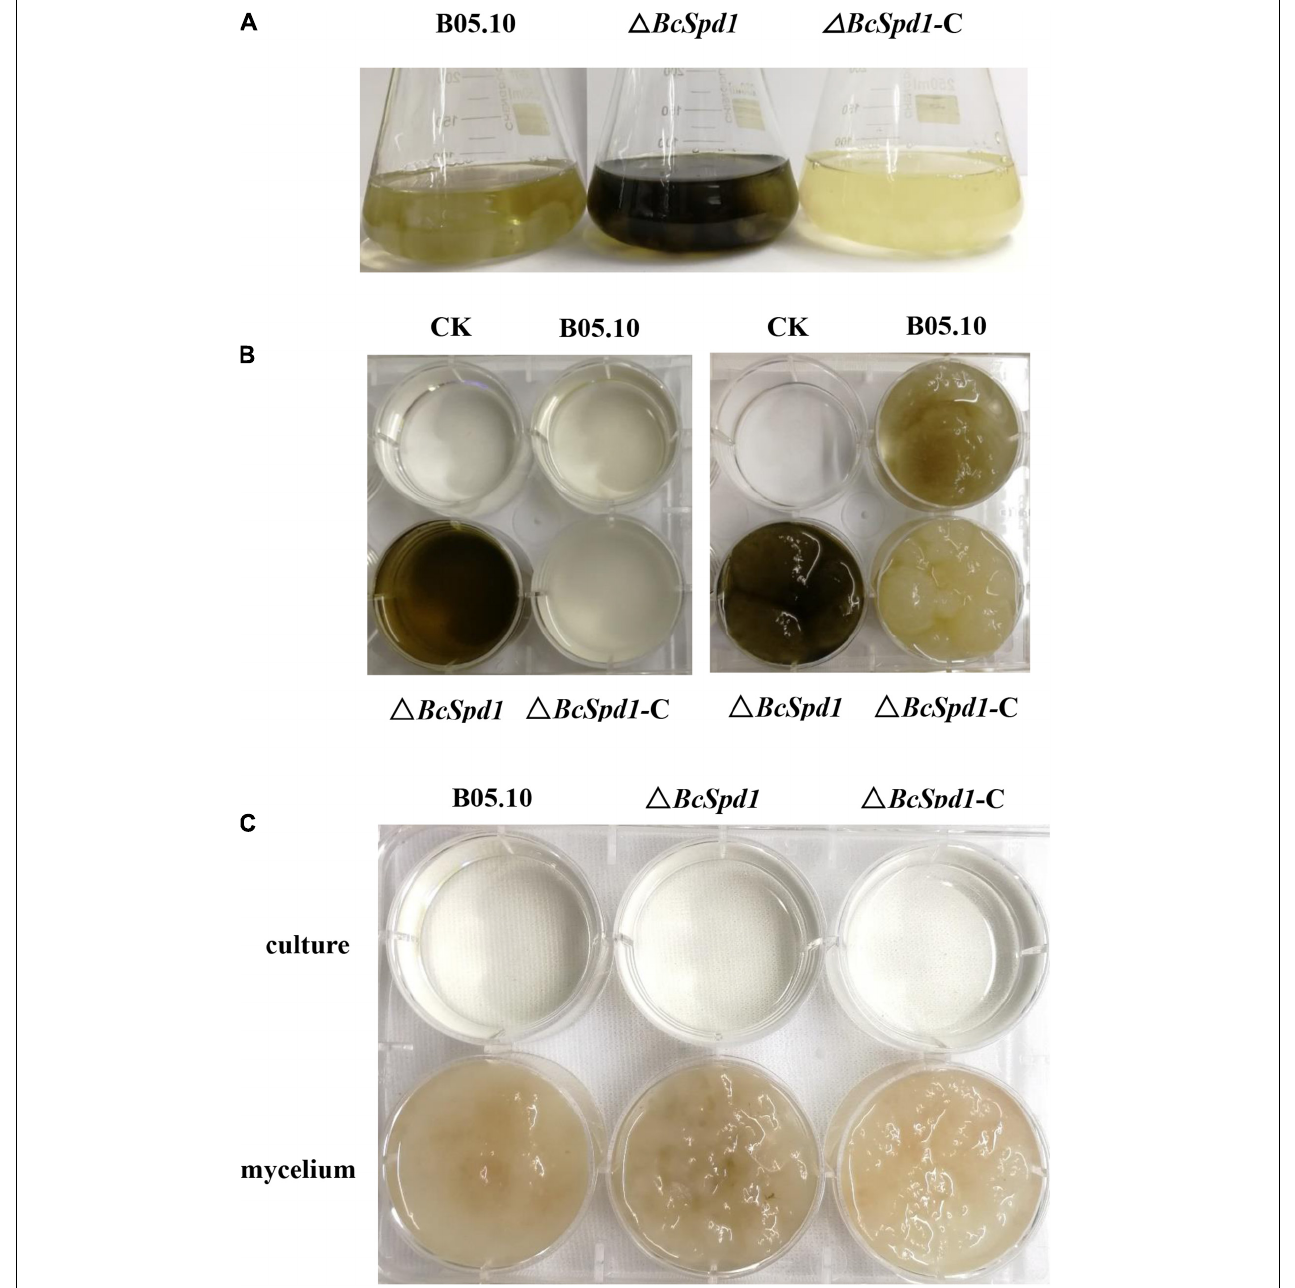
FIGURE 4 | Impact of BcSpd1 deletion on melanin production. (A) Comparisons of mycelial pigmentation among the wild-type strain B05.10, (cid:49) BcSpd1 , and the complemented strain (cid:49) BcSpd1- C after 4 days of incubation on CM liquid medium. (B) Mycelia (right) and the CM buffer (left) from (A) were photographed, respectively. (C) CM liquid medium with 0.01% tricyclazole inhibited the production of melanin both in the (cid:49) BcSpd1 mycelium and in the incubation